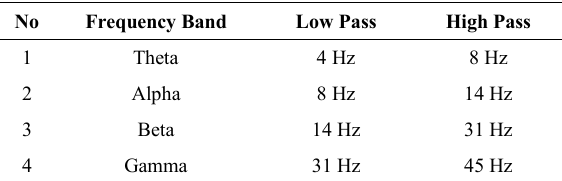
Table 4. Range of low - high pass for each frequency